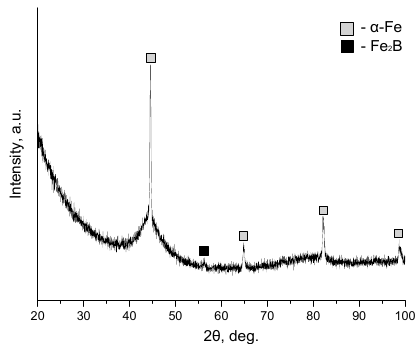
Figure 4. X-ray di ff raction (XRD) pattern of the Fe 66 Cr 10 Nb 5 B 19 feedstock powder (45–75 µ m). Figure 4. X-ray diffraction (XRD) pattern of the Fe 66 Cr 10 Nb 5 B 19 feedstock powder (45–75 µm).